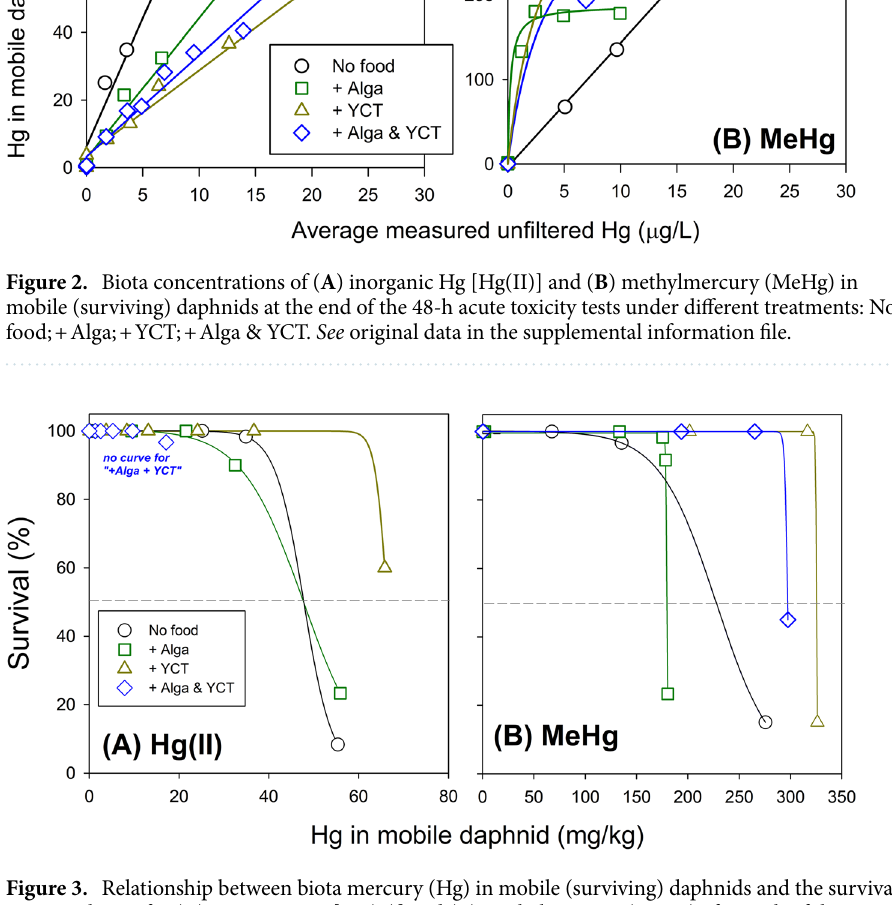
Figure 3. Relationship between biota mercury (Hg) in mobile (surviving) daphnids and the survival rate of the test population for ( A ) inorganic Hg [Hg(II)] and ( B ) methylmercury (MeHg) after 48 h of the acute exposure under different treatments: No food; + Alga; + YCT; + Alga and YCT. Note that the horizontal dash line indicates 50% of survival. In (A), note that no survival curve was plotted for “ + Alga & YCT”